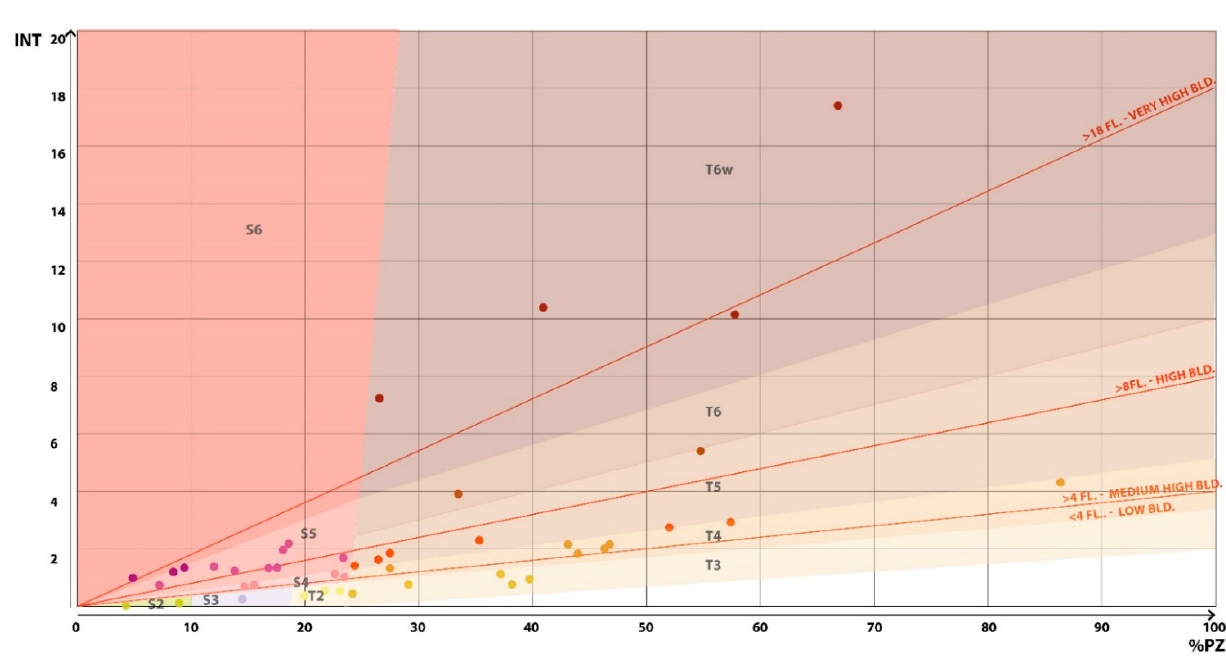
Figure 8. Distribution of building types in individual transect zones. Source: own study.